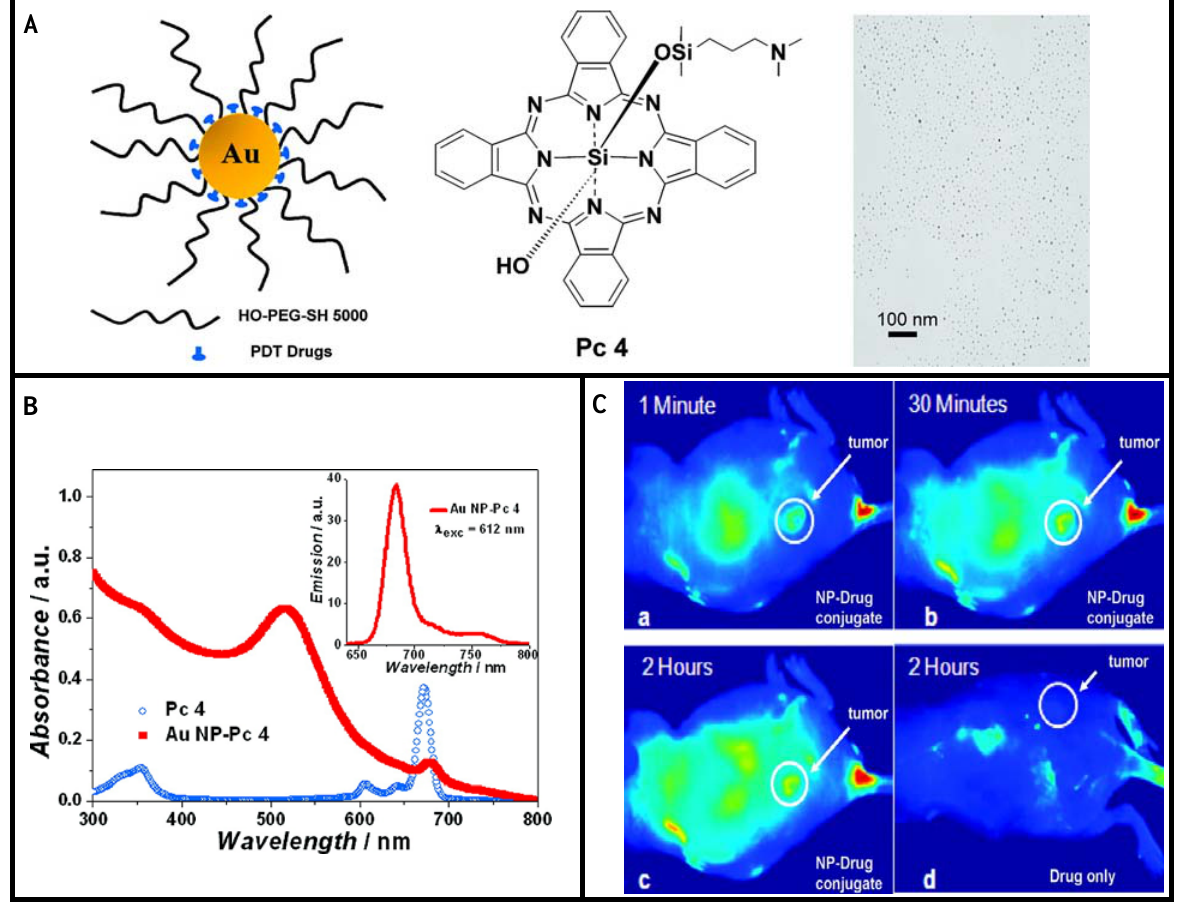
Figure 11. GNPs for PDT. A ) Design of the water-soluble GNPs as a PDT drug delivery agent, structure of the PDT drug (Pc 4), and TEM image of the conjugates. B ) Absorption and emission spectra (inset) of PEGylated GNP-drug conjugates. C ) Fluorescence images of a tumor-bearing mouse after being injected with GNP-drug conjugates, ( a ) 1 min, ( b ) 30 min, and ( c ) 120 min after intravenous tail injection. Any bright signal is due to drug fluorescence, without which no fluorescence signals were detected from the mouse. Unprecedented delivery efficiency and accumulation rate of the drug in the tumor are monitored via the fluorescence increase in the tumor area (white circle). For comparison, a mouse that got only a drug formulation without the GNP vector injected is shown in panel ( d ). No circulation of the drug in the body or into the tumor was detectable 2 h after injection without the GNP as drug vector. Reproduced with permission